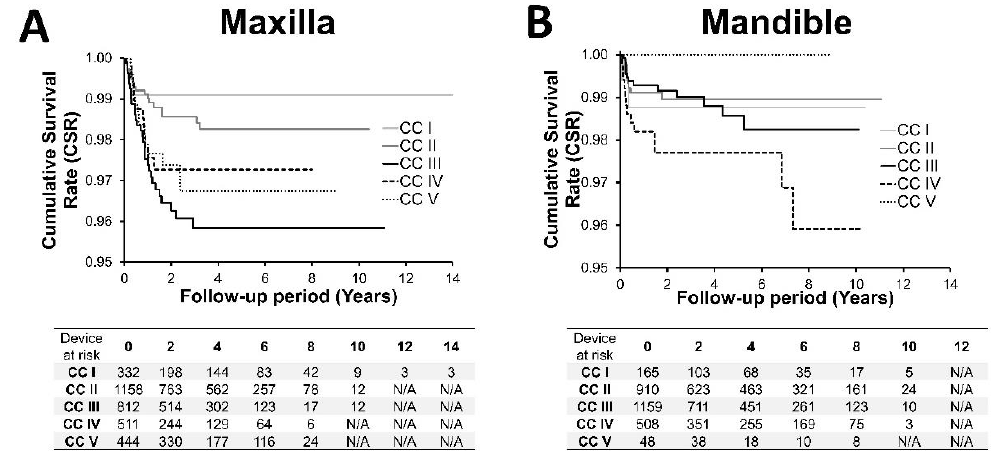
Figure 3. Kaplan – Meier plot, cumulative survival rates for ( A ) maxillary implants and ( B ) mandibular implants as a function of anatomical classifications according to Carames et al. (CCs).